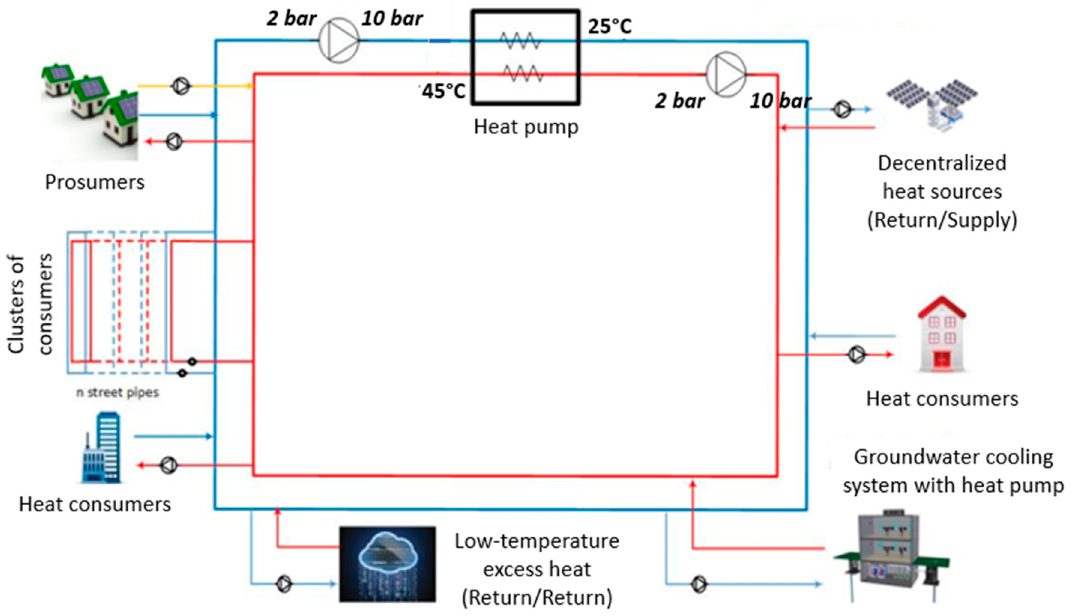
Figure 1. General schematics for the double loop concept.